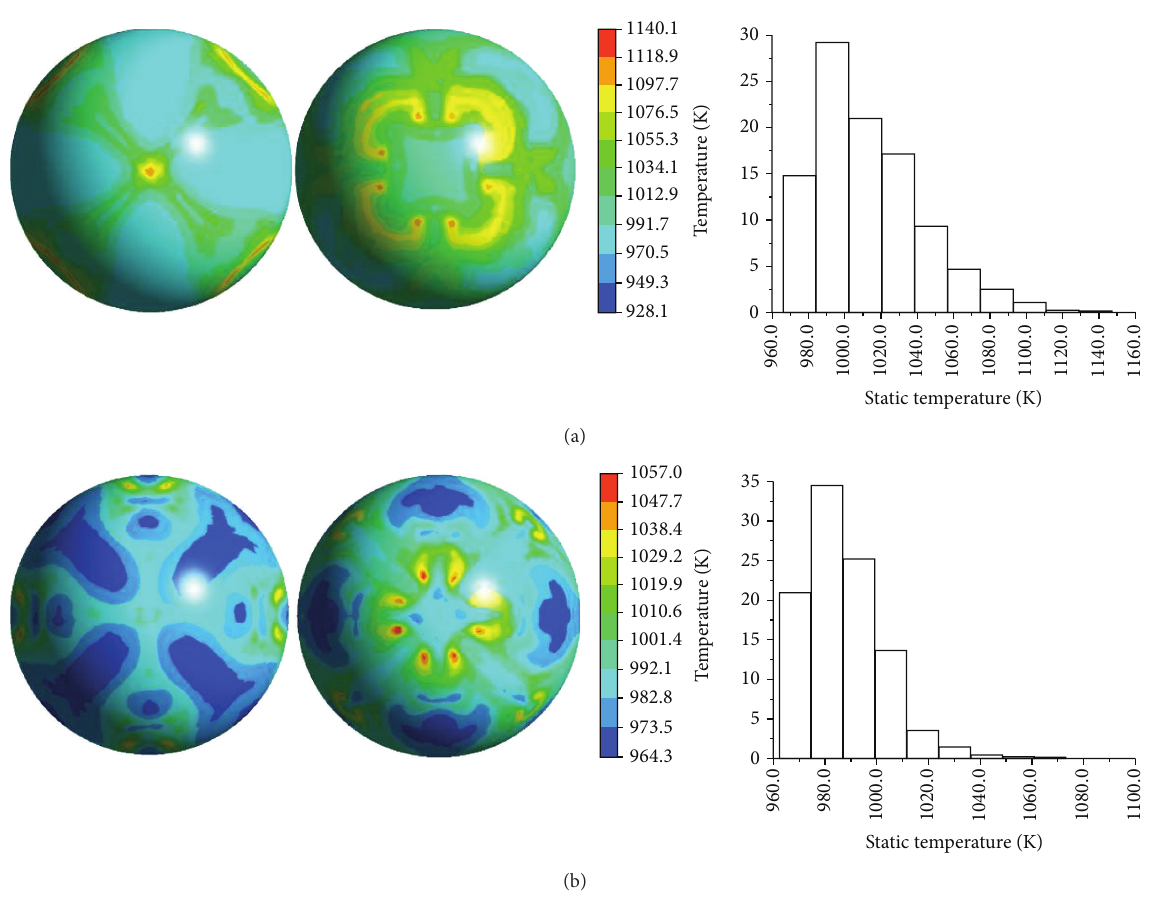
Figure 8: Pebble temperature distribution of BCC (a) and FCC (b) model of Case 1 (view from inlet (left), outlet (middle)) and temperature distribution